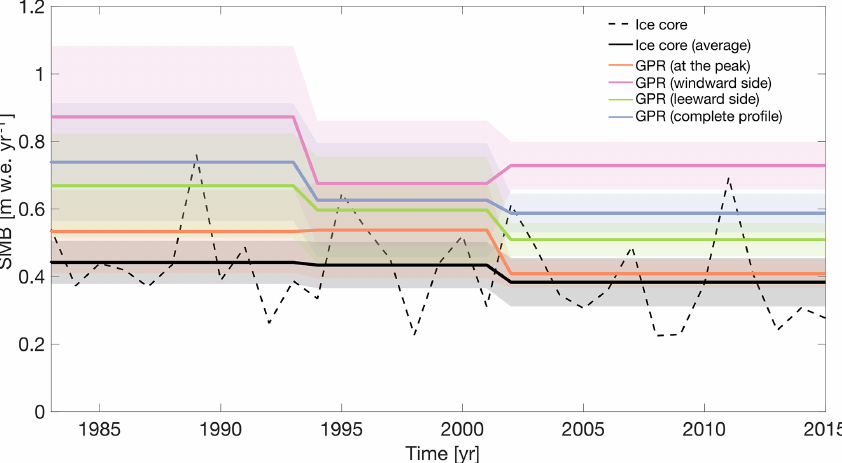
Figure 7. The SMB in time recovered from the FK17 ice core (dashed black line) as well as the SMB recovered from the FK17 ice core averaged for the three time periods (1983–1994, 1994–2002, 2002–2015; solid black line). The solid orange line is the SMB for the same three time periods reconstructed from GPR profile 1 at the peak of the LIR, whereas the solid pink line is the average SMB on the windward side, the light green solid line is the average SMB on the leeward side, and the blue line is the average SMB across the whole GPR profile 1 for the same three time